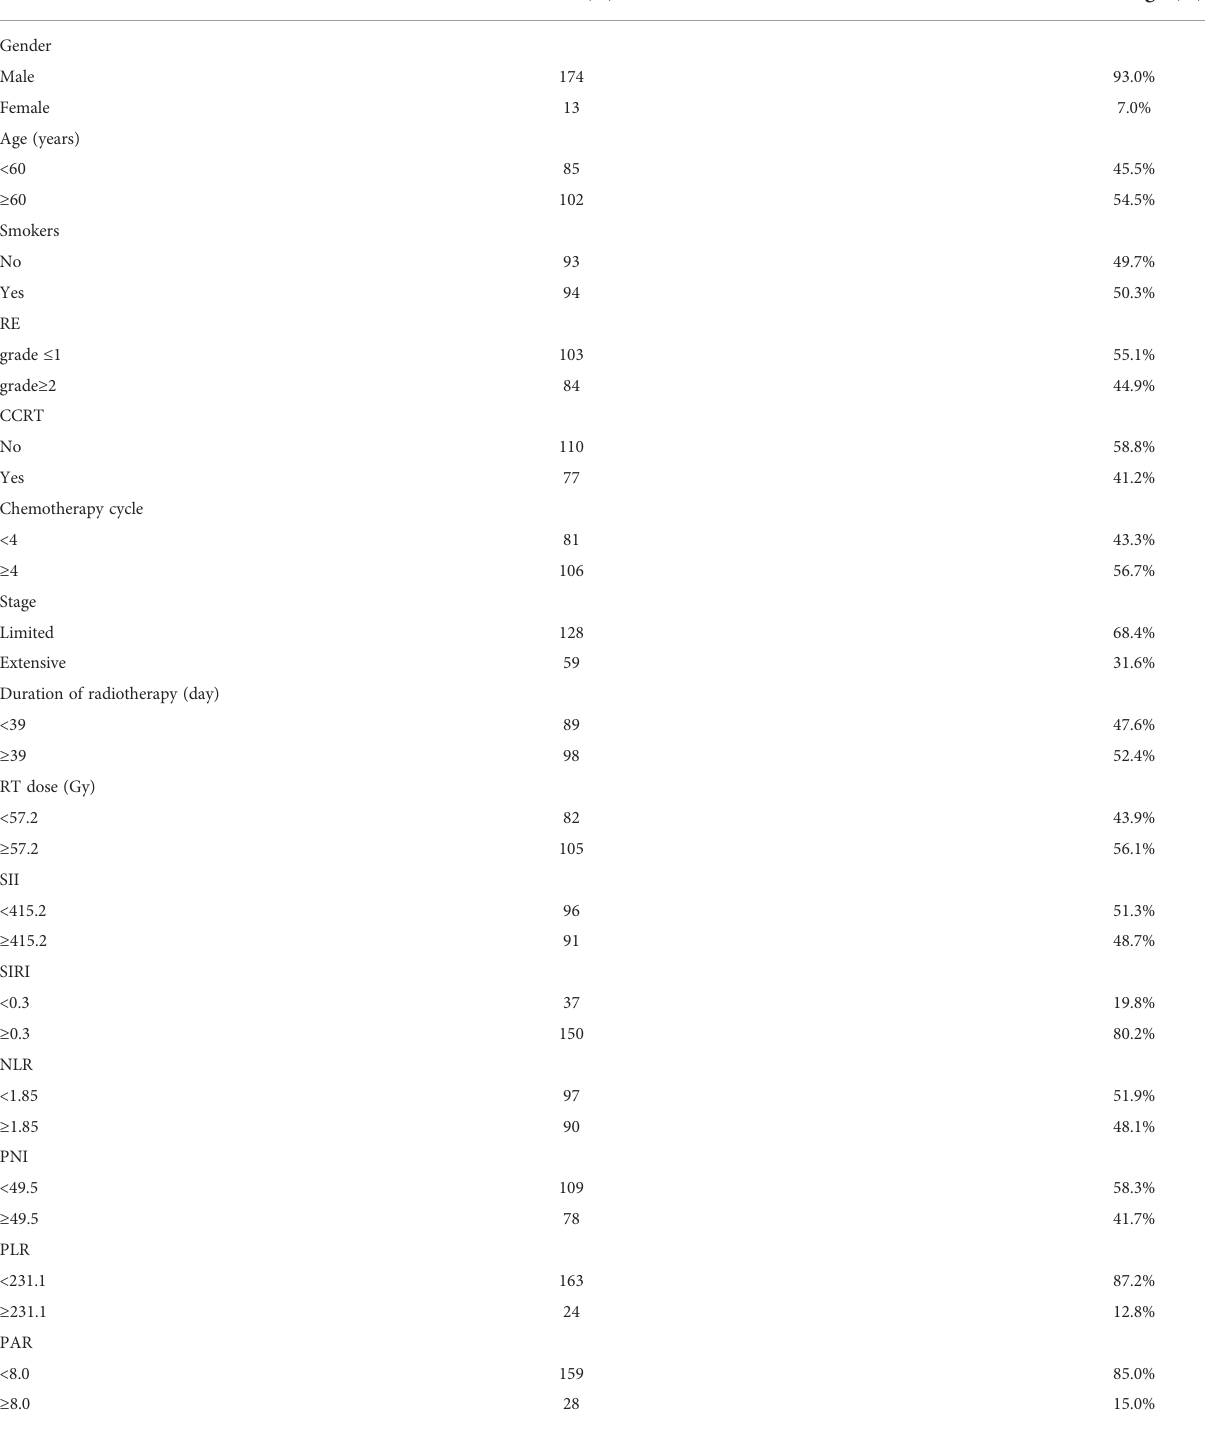
TABLE 1 Baseline characteristics of